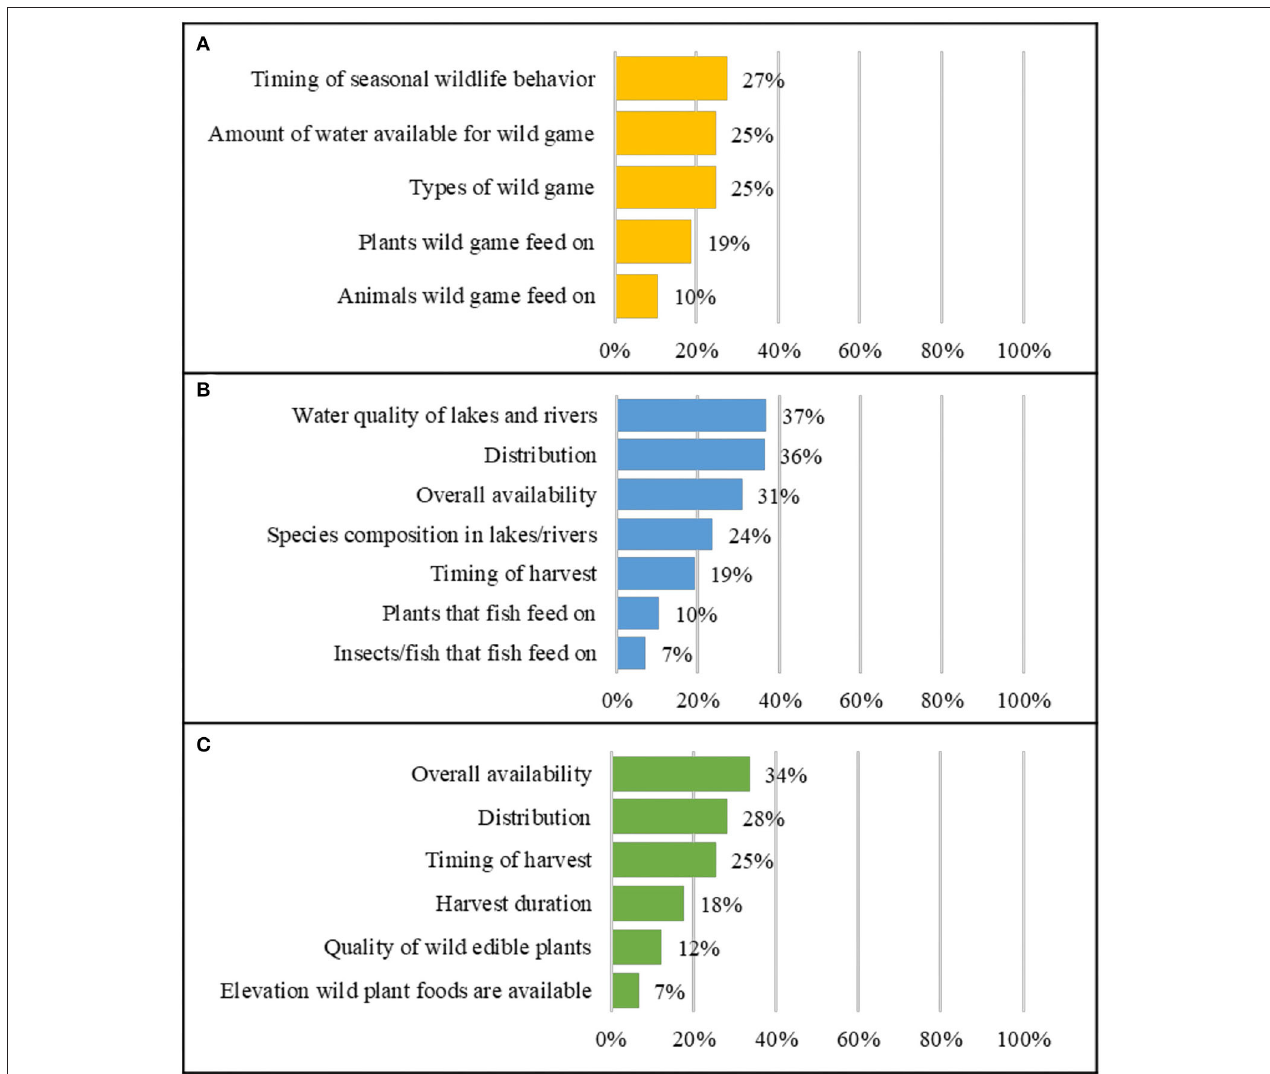
FIGURE 7 | Observed environmental changes. In the past decade observations that have resulted in changes in (A) wild game, (B) fish, and (C) edible plant populations.